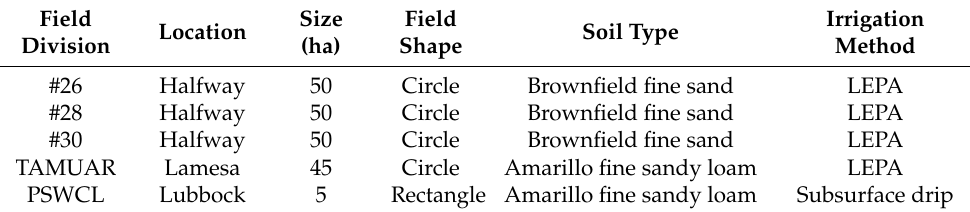
Figure 1. Map of study field locations in Hale, Lubbock, and Lamesa counties, Texas, USA. Table 1. Summarized information on the study fields and irrigation